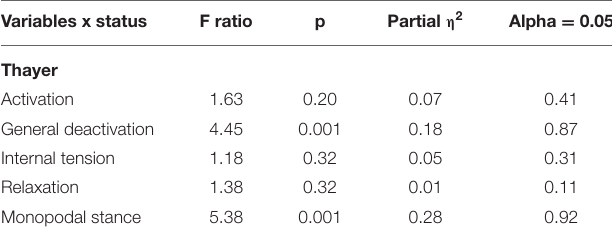
TABLE 6 | Analyses for the interaction between the variables and the condition, PA vs.